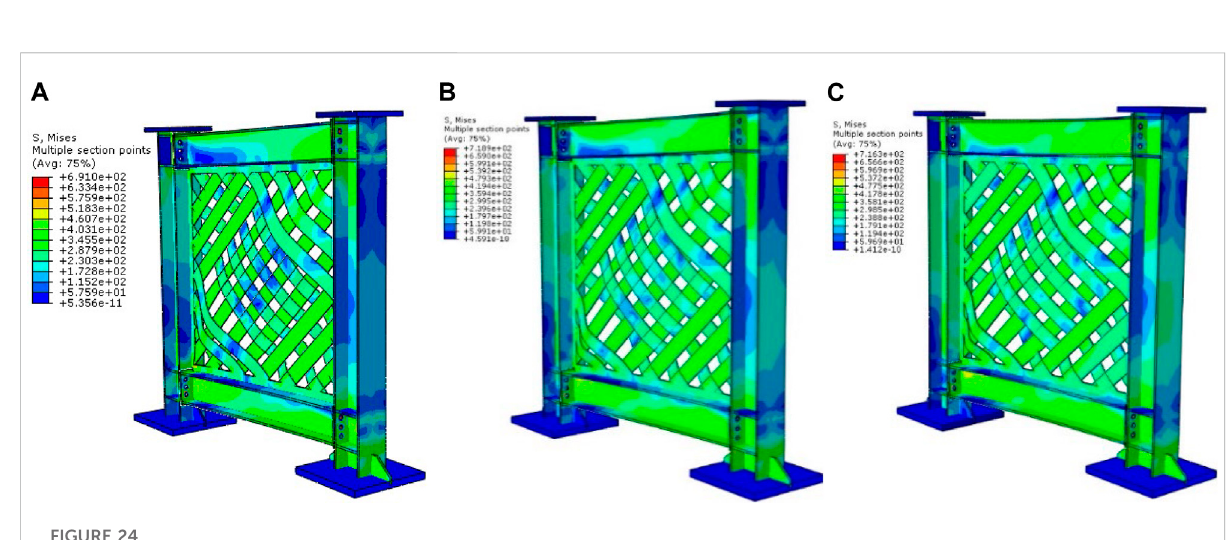
FIGURE 24 The Von-Mises stress and the post-buckling response of the parametric models: (A) SW-4, (B) SW-5, and (C) SW-6.